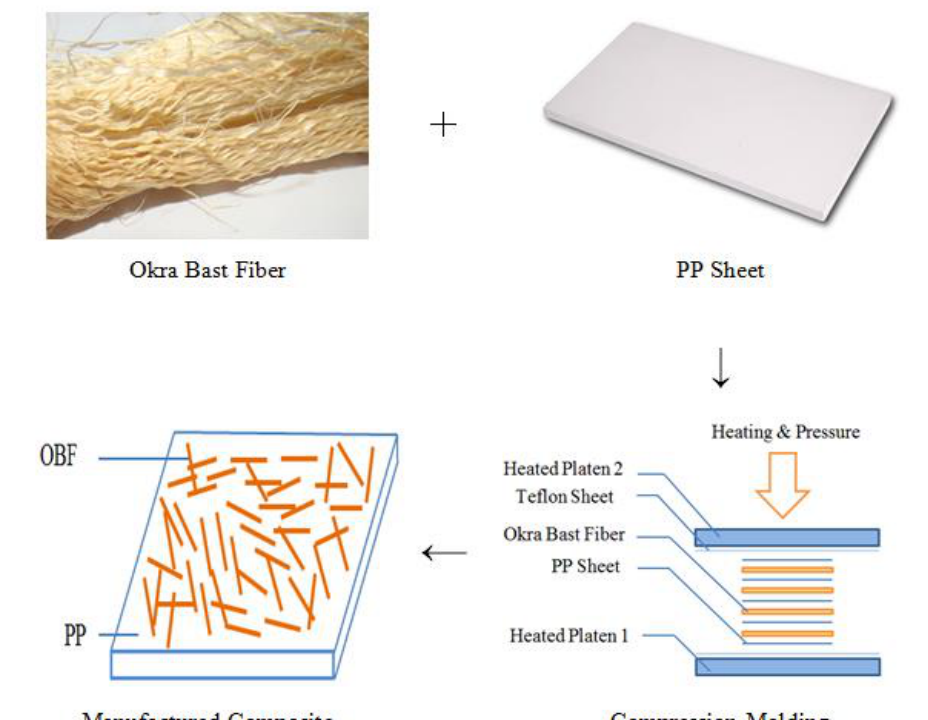
Figure 3: Fabrication Model of Composite